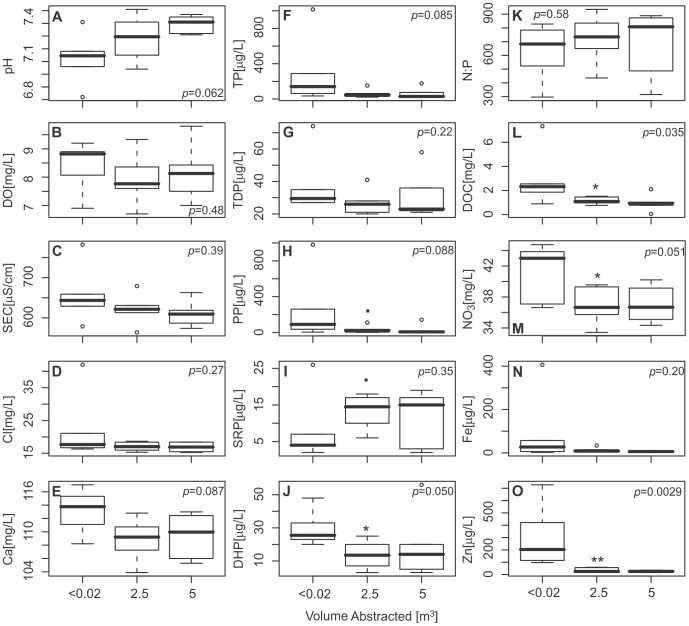
Grouped summary chemistry results.A) pH, B) DO, C) SEC, D)Cl, E)Ca, F)TP, G)TDP, H)PP, I)SRP, J)DHP, K) N:P(molar), L)DOC, M)NO3, N)Fe and O)Zn. Box = interquartile range, horizontal bar = median value, range of whiskers = ±1.5x interquartile range, outlier values are displayed = values that fall outside the range of whiskers. P values calculated using Kruskal-Wallis test. Wilcoxon rank tests were used to investigate differences between two pairs of groups, significance denoted as follow: **0.01, *0.05, ▪0.1.